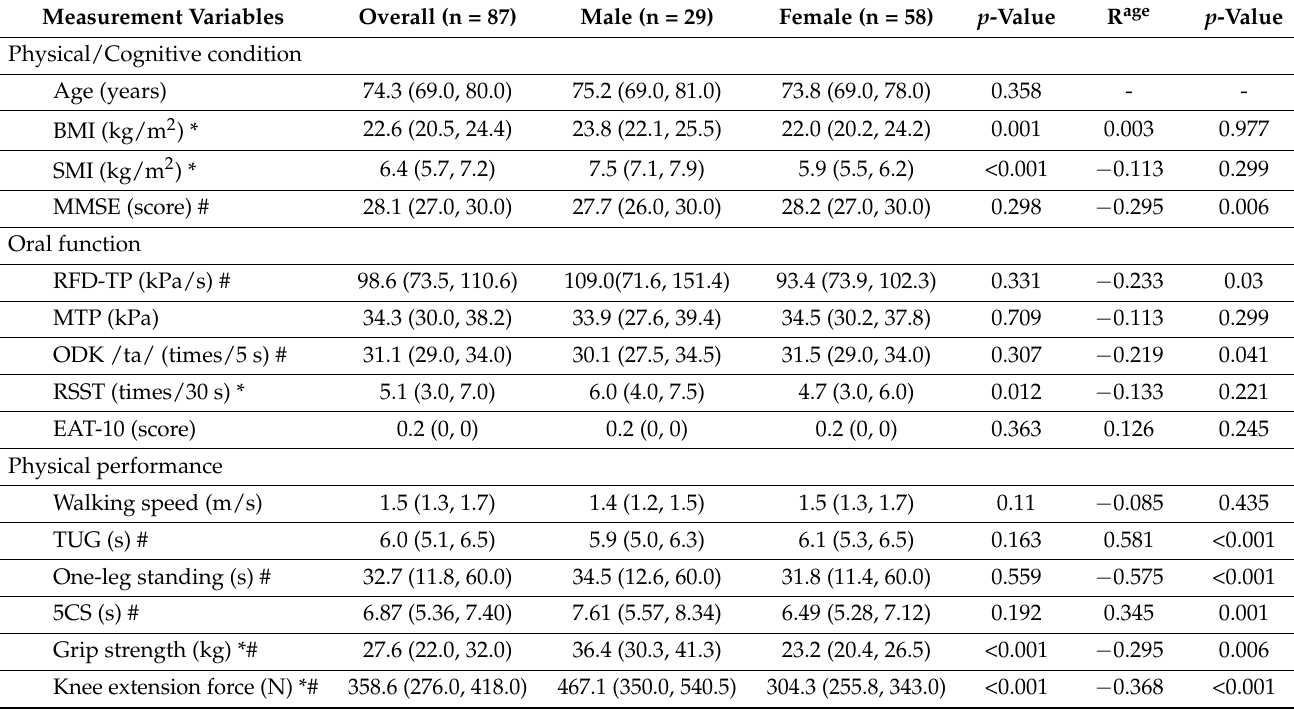
Table 1. Summary of participant characteristics and relationship with